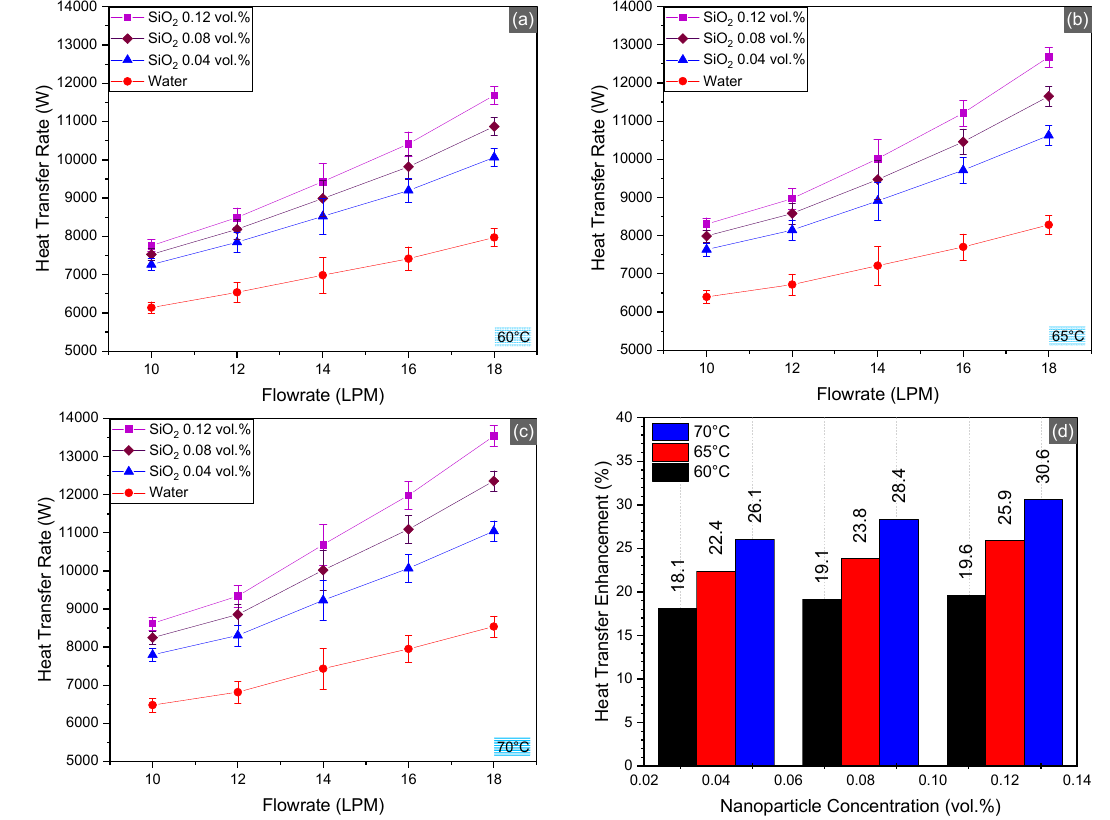
Figure 6. Convection heat transfer in the radiator at inlet temperatures 60–70 ℃ ( a – c ) and average enhancement in heat transfer rate for SiO 2 /water nanofluid as compared to the basefluid ( d ).